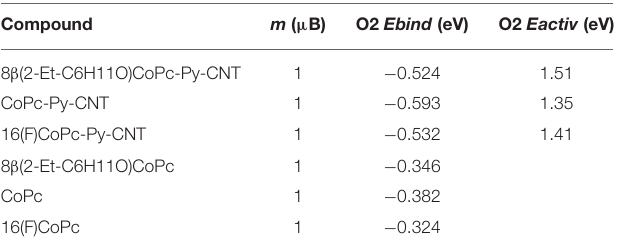
TABLE 2 | Theoretical results for the magnetic moment ( m ), O 2 binding energy ( E bind ), and O 2 activation energy ( E activ ) for 8(2-Et-C 6 H 11